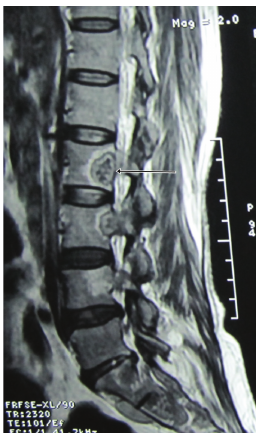
Figure 4: Arrowhead showing altered marrow signal intensity with abnormal soft tissue lesion at L2 vertebra.